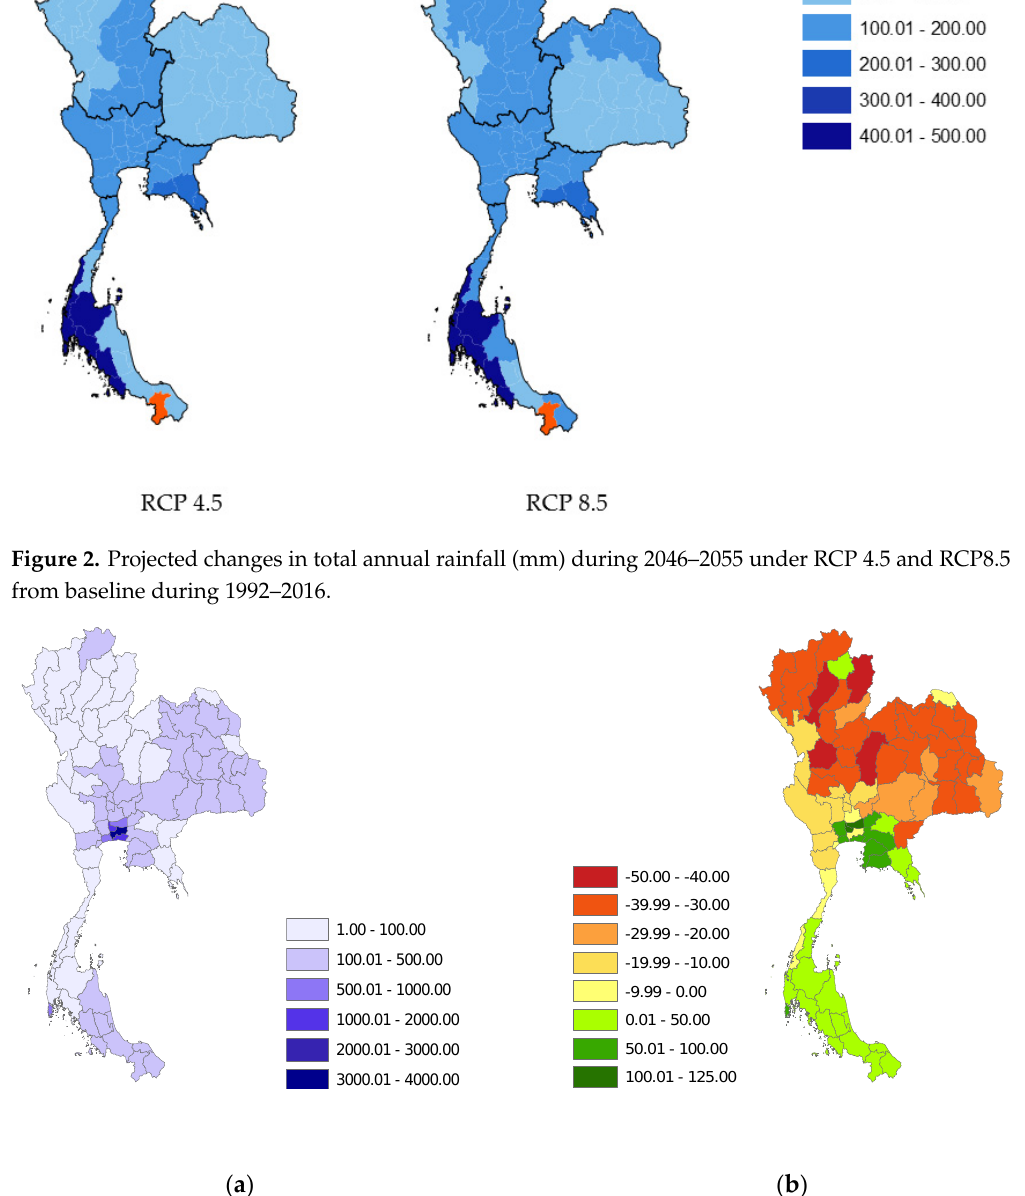
Figure 3. Projected changes in population density (people / km 2 ) during 2046–2055 under scenario of moderate fertility rate. ( a ) Baseline of population density in 1992–2016 (people / km 2 ); ( b ) percent of change of population density in 2046–2055 from baseline.